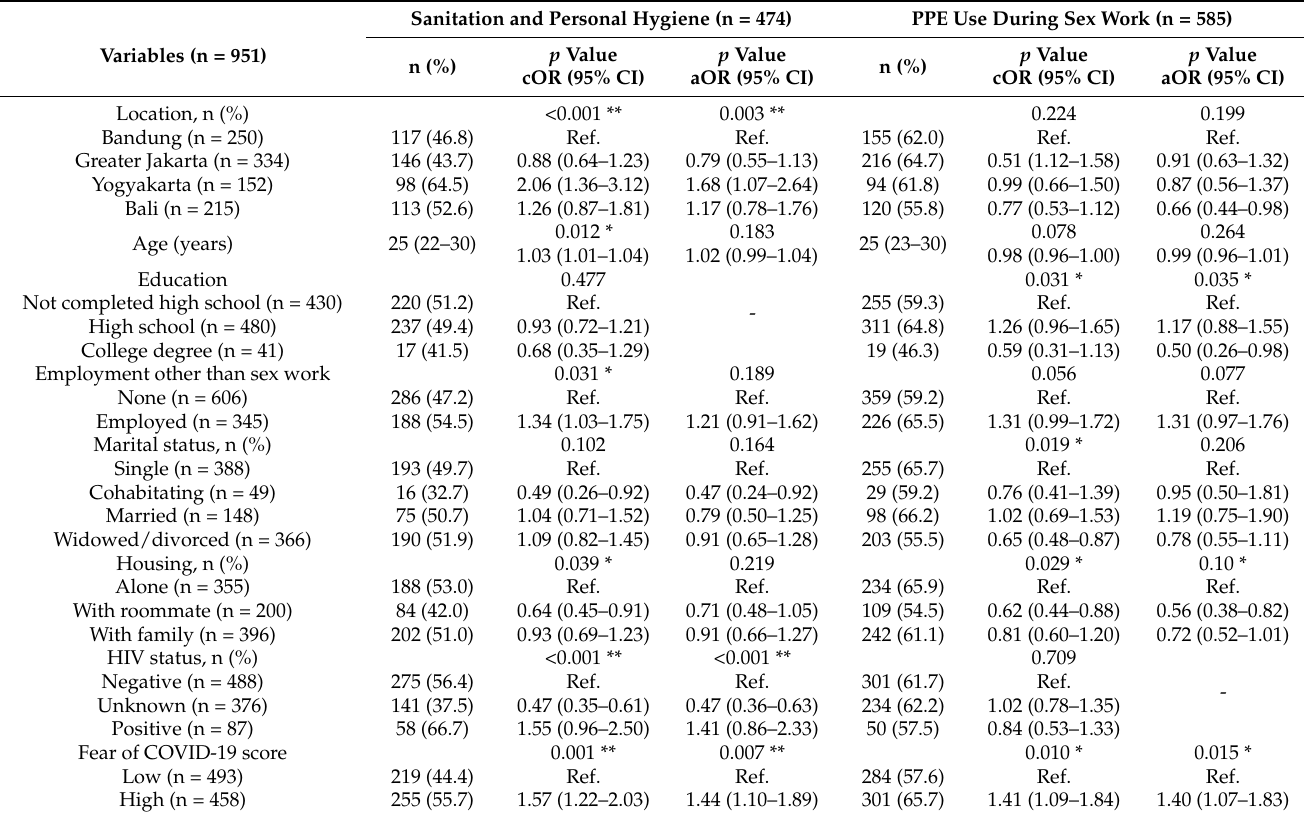
Table 3. Determinants of adherence to COVID-19 prevention protocol for sex